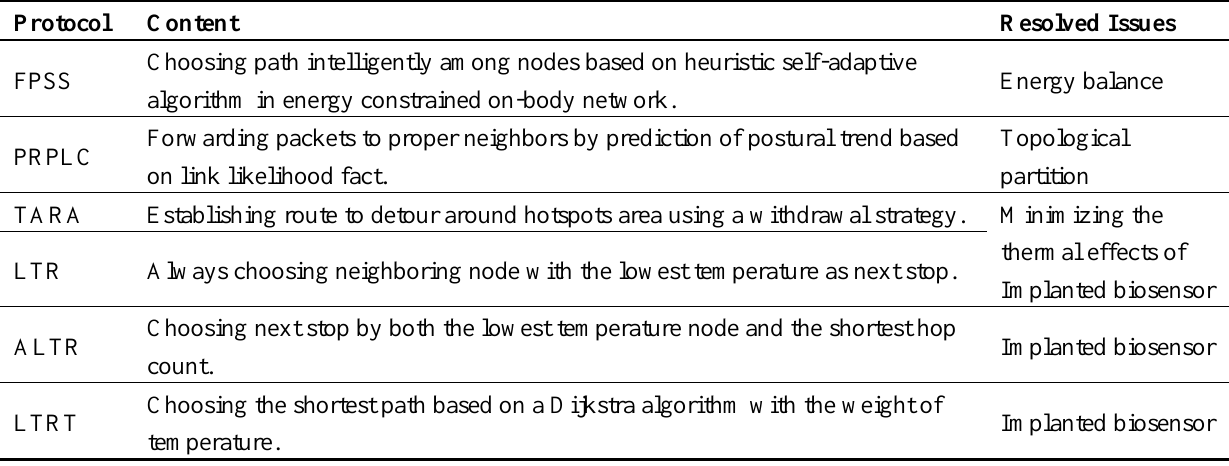
Table 3. Summary of existing BSN routing